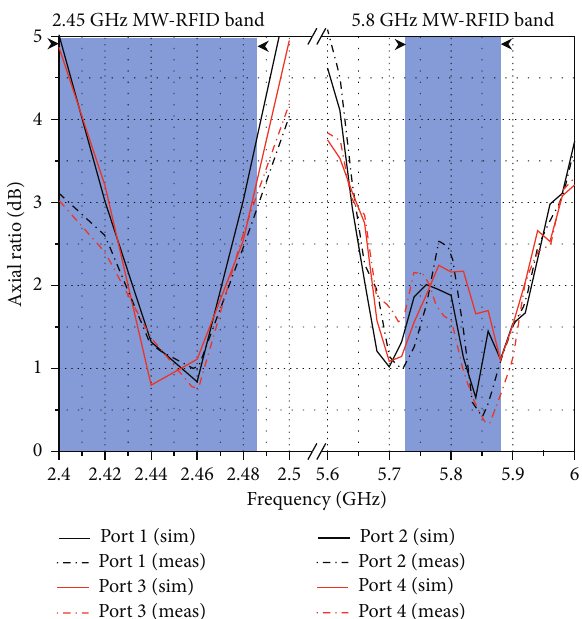
Figure 15: Simulated and measured AR in MIMO